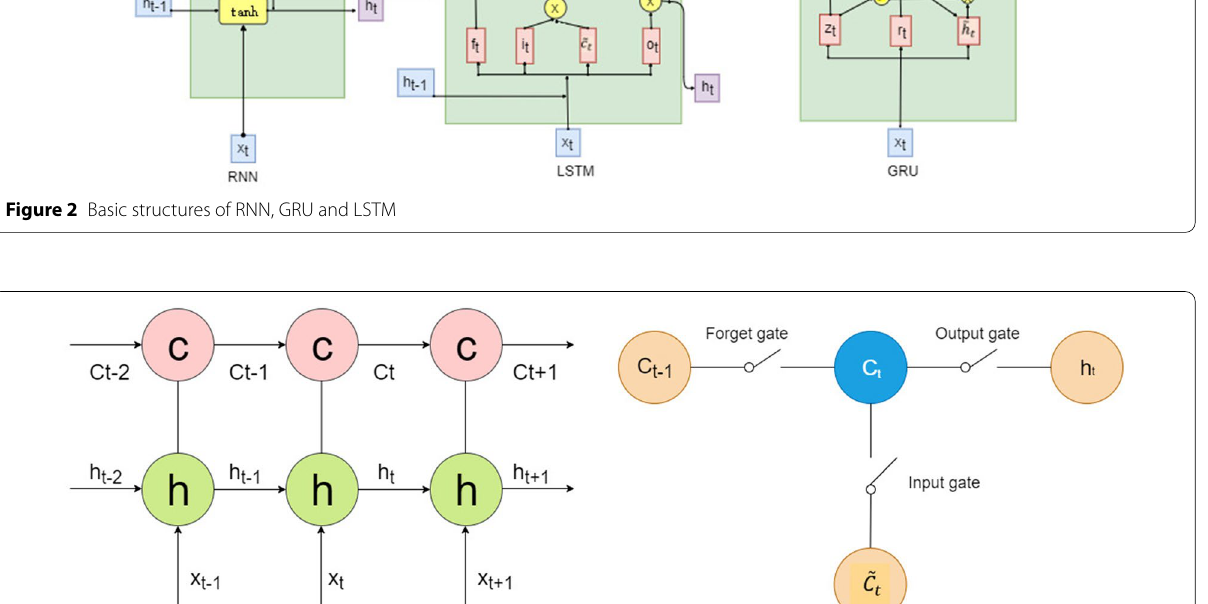
Figure 3 Cell state and three gates in